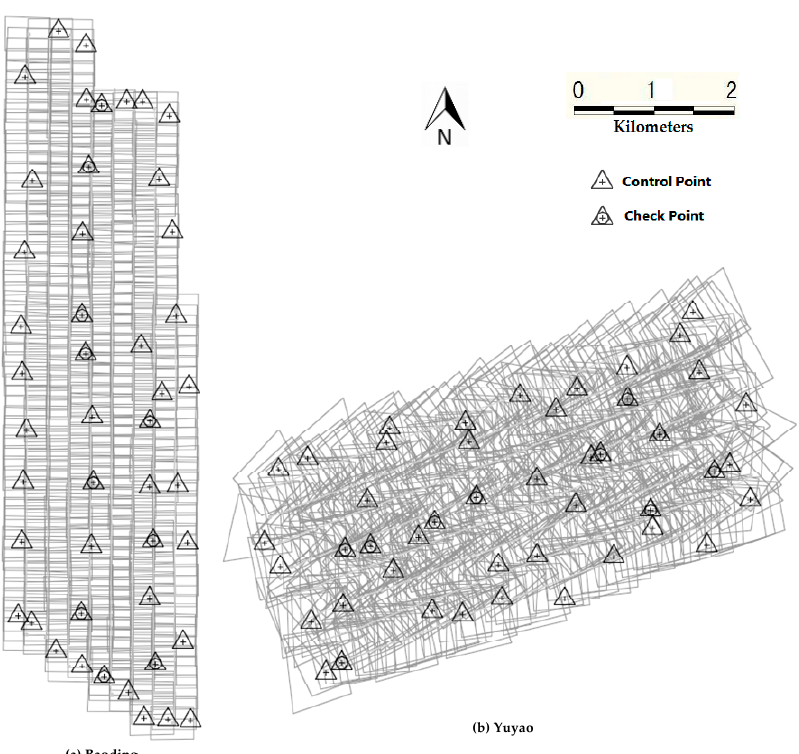
Figure 6. Schematic drawings of the experimental datasets. ( a ) Baoding; ( b ) Yuyao.